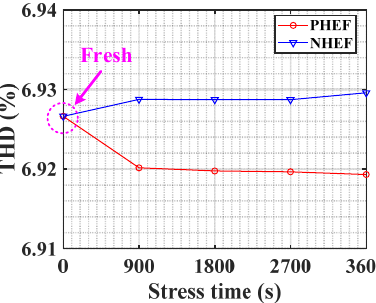
Figure 35. THD of the output current of the CSI according to HEF stress.